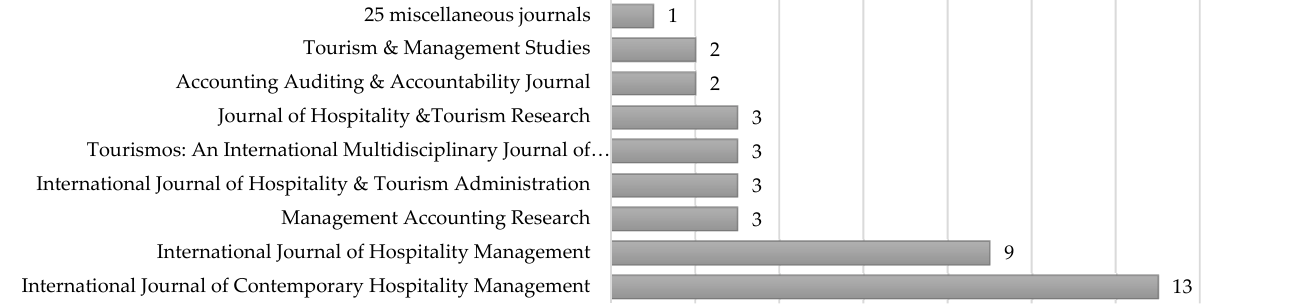
Figure 3. Journals represented in the sample.